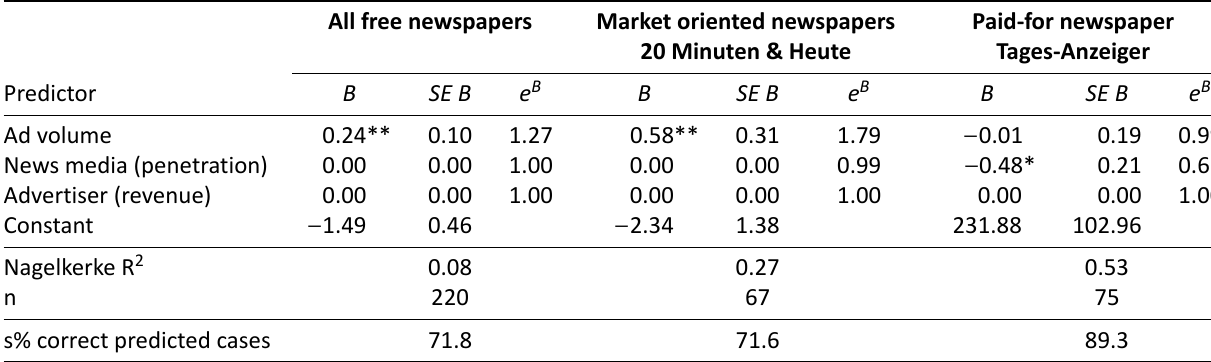
Table 5. Aggregated model for journalists’